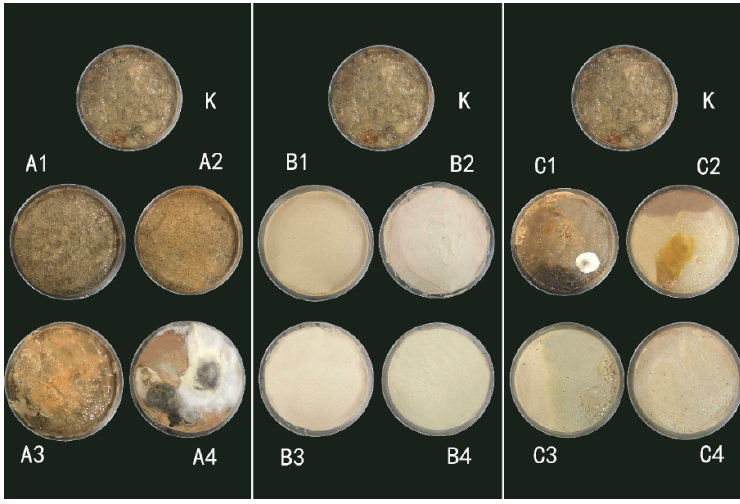
Figure 1. All soy meal samples were conditioned at 28 ◦ C and 95% RH for 15